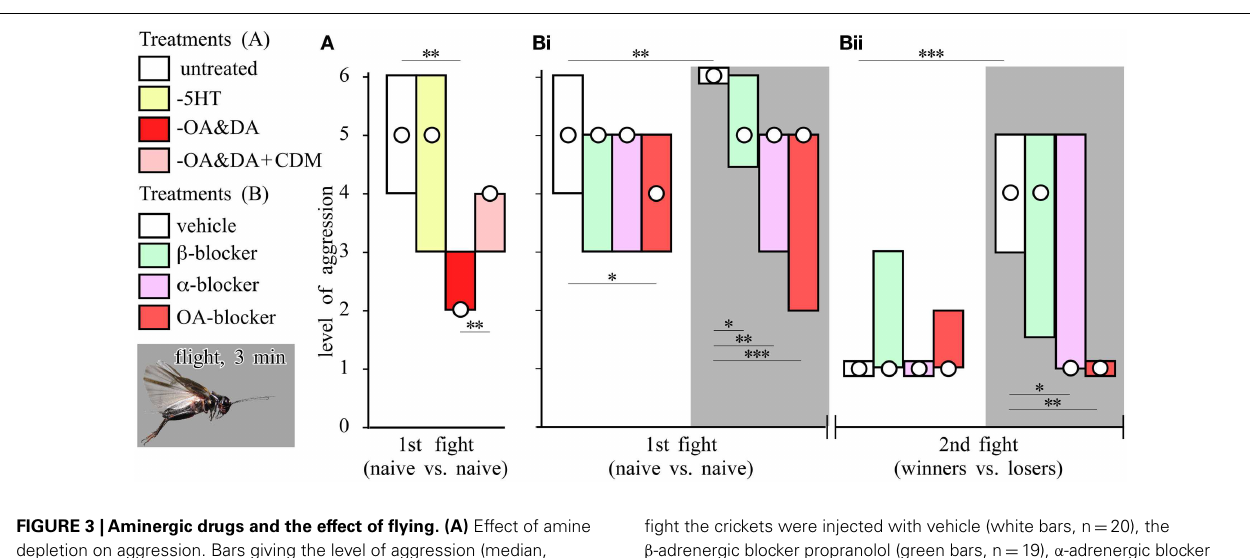
FIGURE 3 |Aminergic drugs and the effect of flying. (A) Effect of amine depletion on aggression. Bars giving the level of aggression (median, interquartile range) for fights between pairs of socially inexperienced crickets (initial fight) that were either untreated (white bar, n = 24), serotonin depleted (yellow bar, − 5HT, n = 27), octopamine/dopamine depleted (red bar, − OA/DA, n = 45) or octopamine/dopamine depleted and treated with the octopamine agonist CDM (pink bar, − OA/DA + CDM, n = 10). (B) Effect of aminergic blockers on aggression and the effect of flying ( Bi initial fight; Bii winners vs. losers 15min later). Before the initial